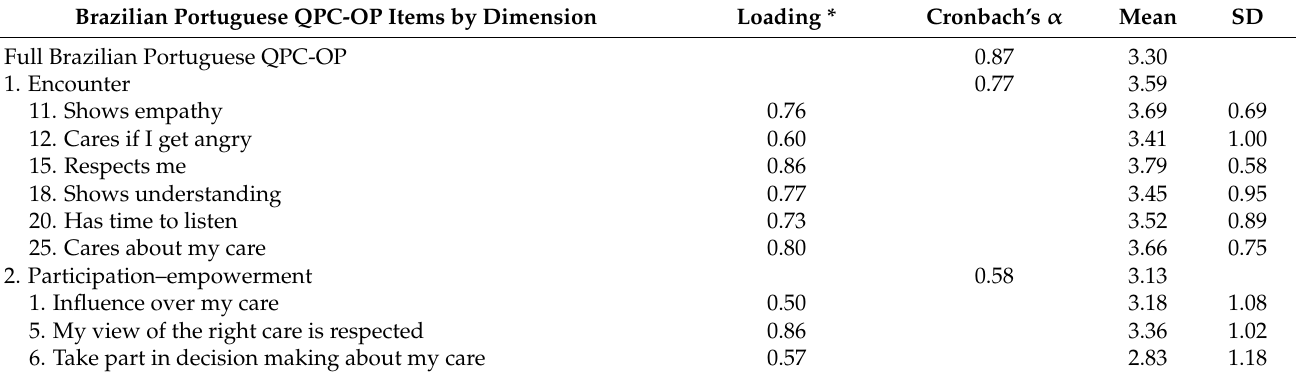
Table 2. Summary statistics of confirmatory factor analysis of the Brazilian Portuguese QPC–OP for patients of Brazilian outpatient services ( n =